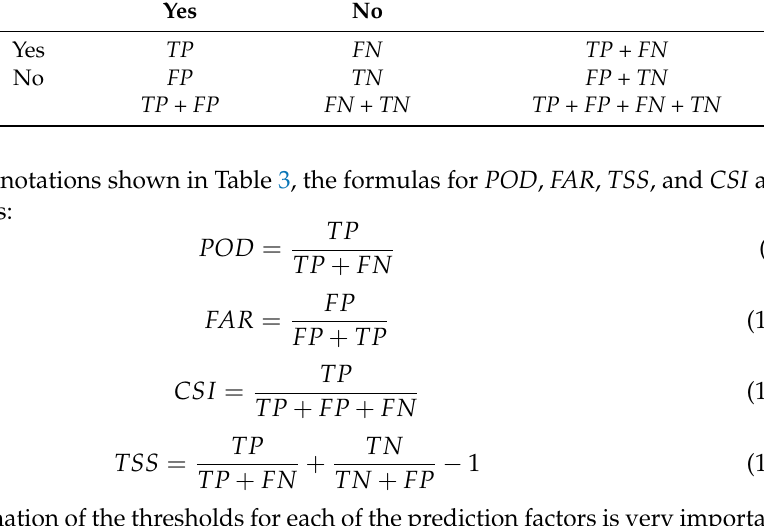
Figure 2. GNSS-PWV (blue curves) and RS-PWV (red dots) time series over the ZMA1 station in the 7-month period from November 2013 to May 2014. Table 3. Schematic 2 × 2 contingency table for predicted events and observed events.